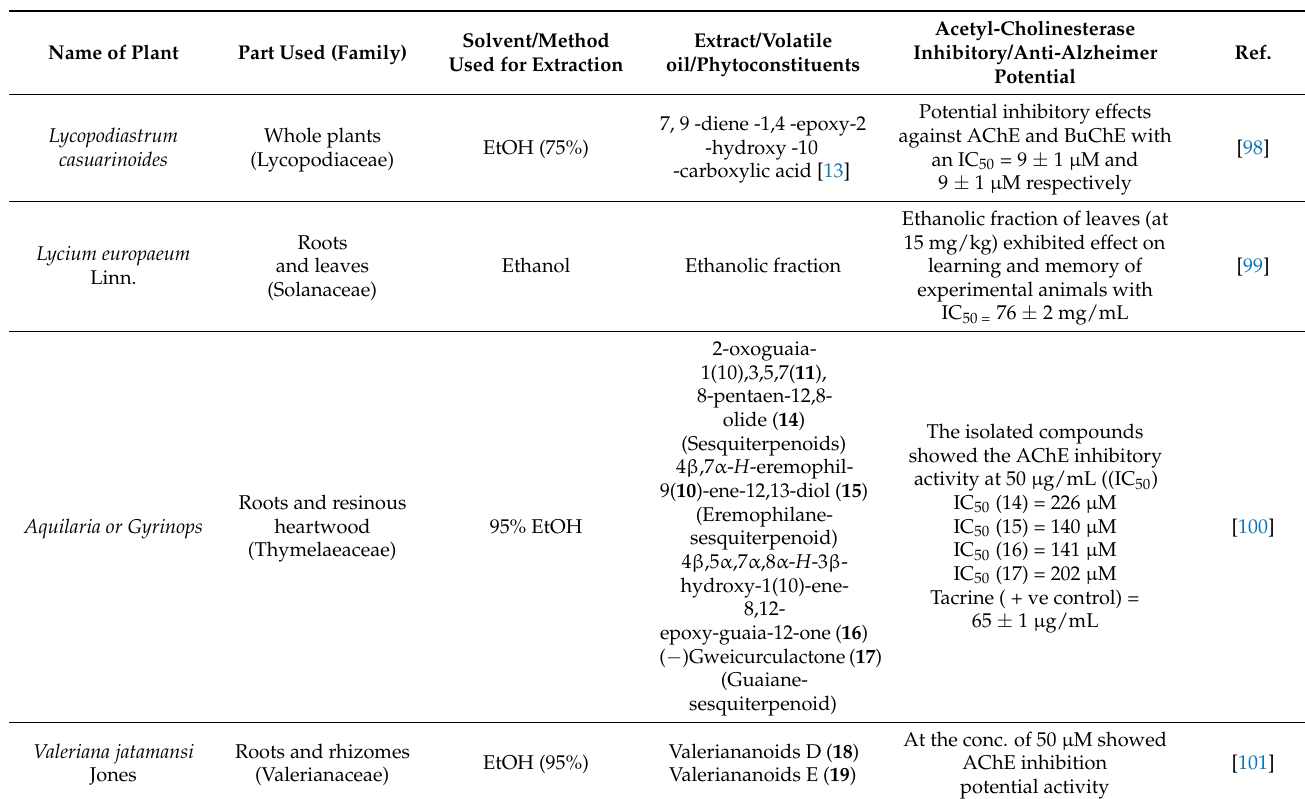
Table 1. Some Sesquiterpenoids that haveanticholinesterase inhibitory